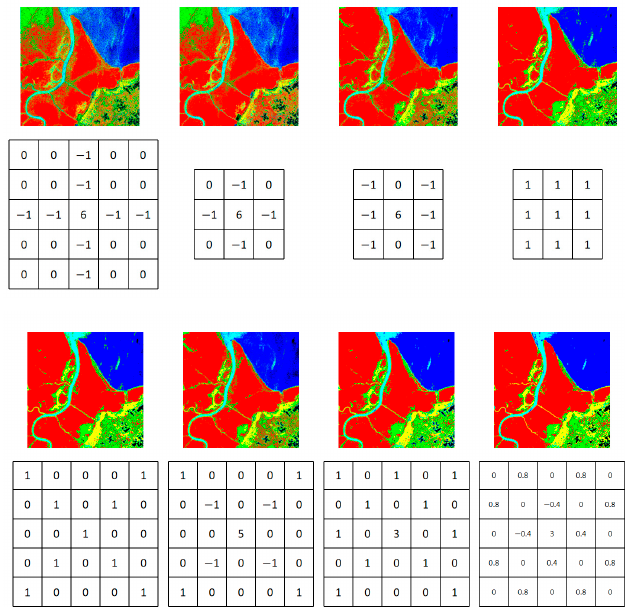
Figure 5. Different effects of different convolution kernels.